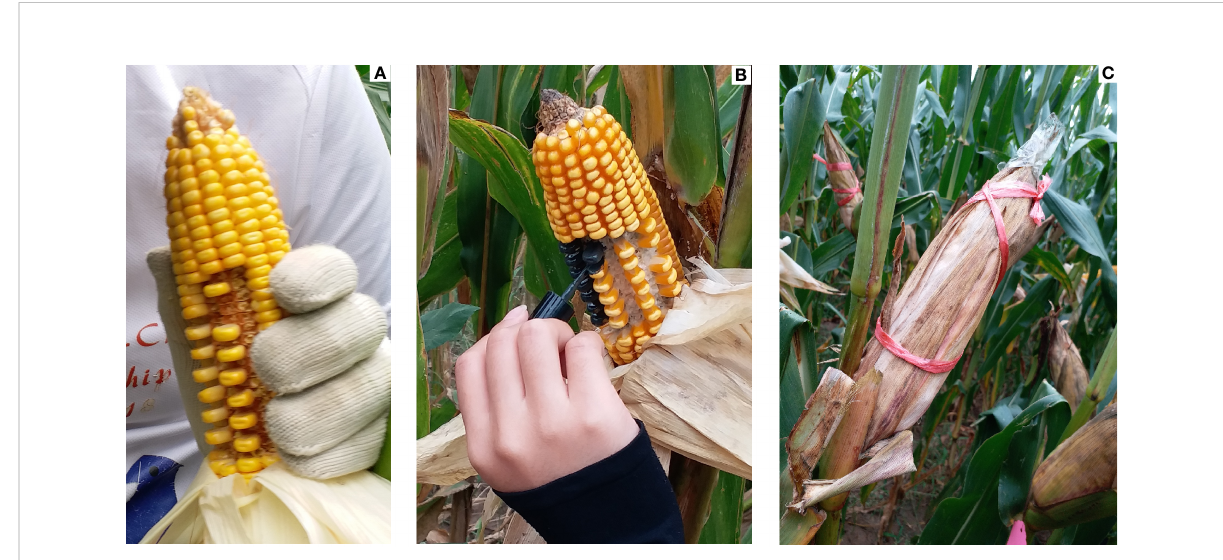
FIGURE 2 The grain-coated experiment process. (A) Alternated removal of middle grains in alternating rows, (B) coating of the 20 grains, (C) closed husk and bound the